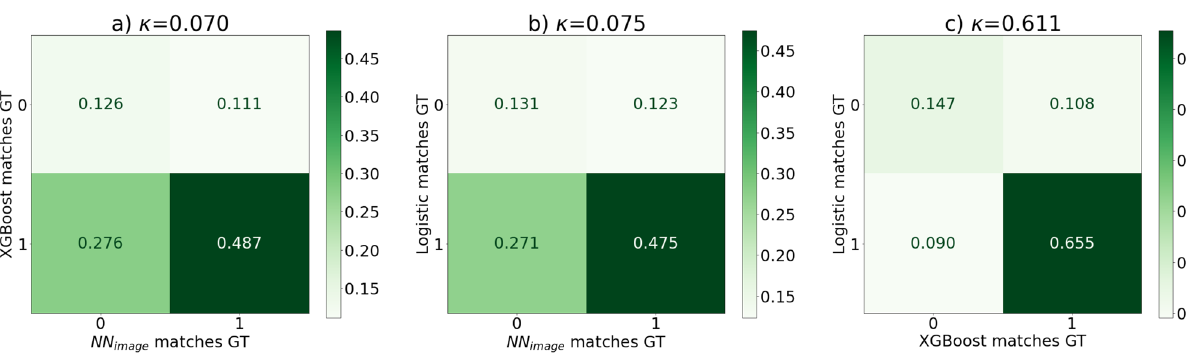
Figure 4. ( a ) XGBoost baseline model agreement with the ground truth against the image-only neural network ( NN image ) agreement with the ground truth (GT), we can see that the XGBoost model is superior ( b ) shows similar result, as the logistic model agrees with the ground truth whilst the NN image model does not and the NN image model performs poorly also when the baseline models are wrong, ( c ) shows the baseline models against each other to see that similar prediction information content models miss and match together. All model comparisons have their Cohen-kappa scores calculated above the corresponding confusion matrices. We can see that the image-based networks have very low agreement with the baseline models. The numbers in each segment represent the fraction of cases corresponding to the specific